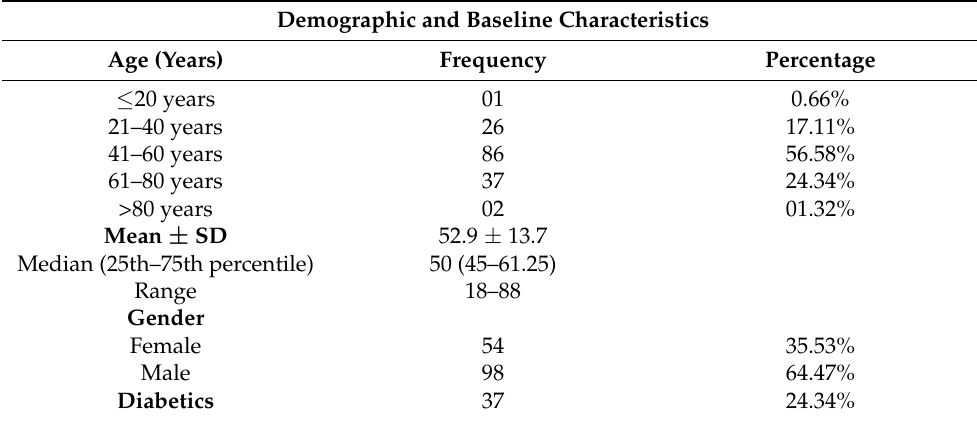
Table 3. Distribution of demographic and baseline characteristics of study.